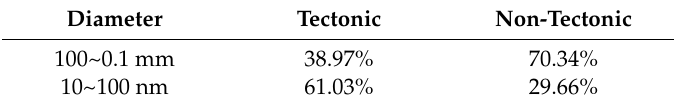
Table 3. Pore size distribution derived from the mercury intrusion analysis.